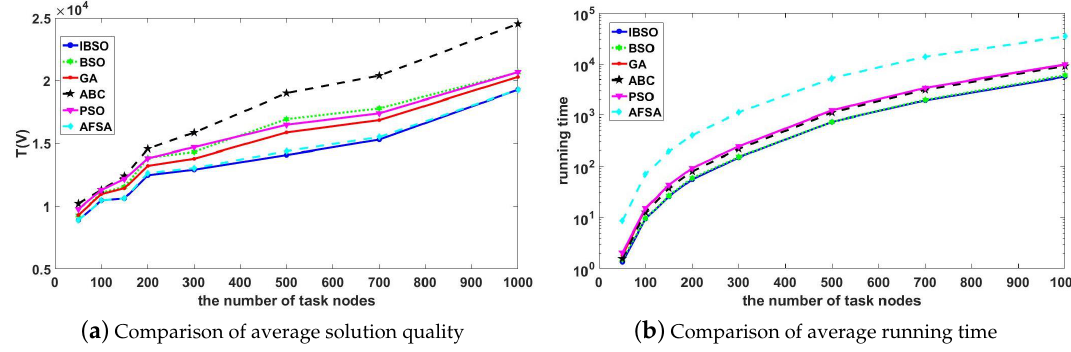
Figure 7. Comparison of experimental results in solution quality and running time.